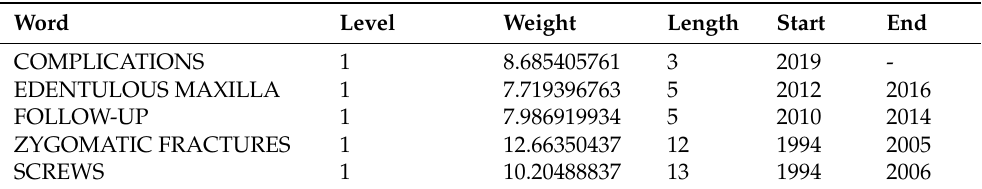
Table 4. List of citation bursts among the ISI keywords. “Complications” stands as the most recent keyword, with “screws” representing the most cited keyword and followed by “zygomatic fractures”, “follow-up”, and “edentulous